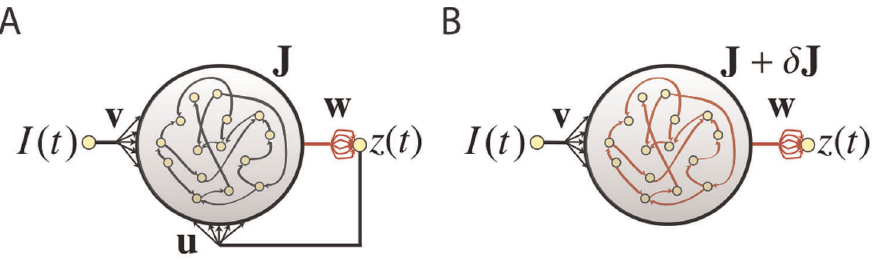
Figure 1. The two recurrent network architectures being considered. The nets are shown with non-modifiable connections shown in black and modifiable connections in red. Both networks receives input I ( t ) , contain units that interact through a sparse weight matrix J , and produce an output z ( t ) , obtained by summing activity from the entire network weighted by the modifiable components of the vector w . (A) The output unit sends feedback to all of the network units through connections of fixed weight u . Learning affects only the output weights w . (B) The same network as in A, but without output feedback. Learning takes place both in the network through the modification J ? J z d J , to implement the effect of the feedback loop, and at the output weights w , to correctly learn z ( t )